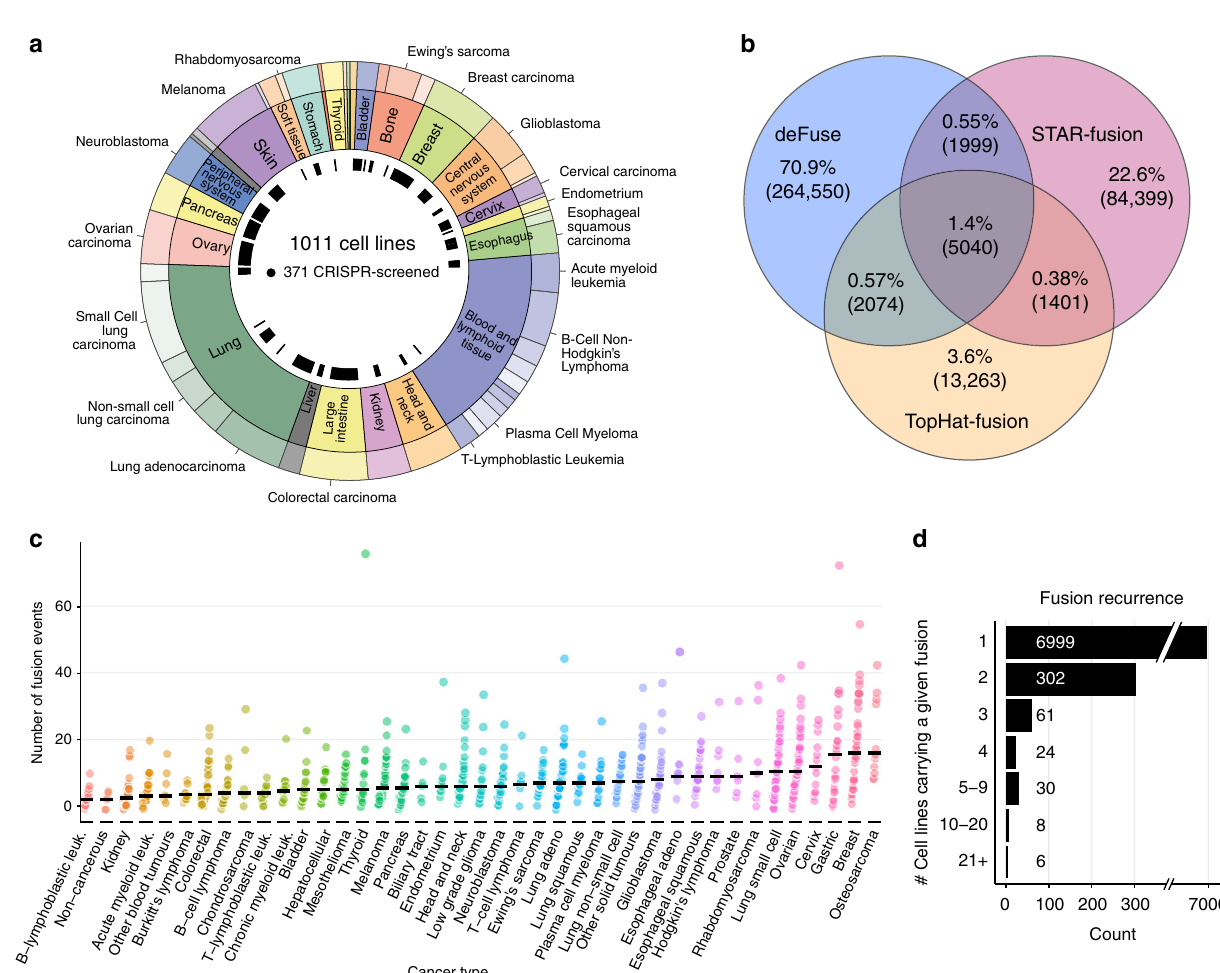
Fig. 1 Landscape of gene fusions in cancer cell lines. a Tissues (inner ring) and cancer types (outer ring) represented by the cell lines and CRISPR dataset used for this study. b Fusion transcript calls using three algorithms and their overlap. c Frequency of gene fusion events in cancer cell lines, separated by cancer type. The black line is the median. d Fusion event recurrence in cancer cell lines